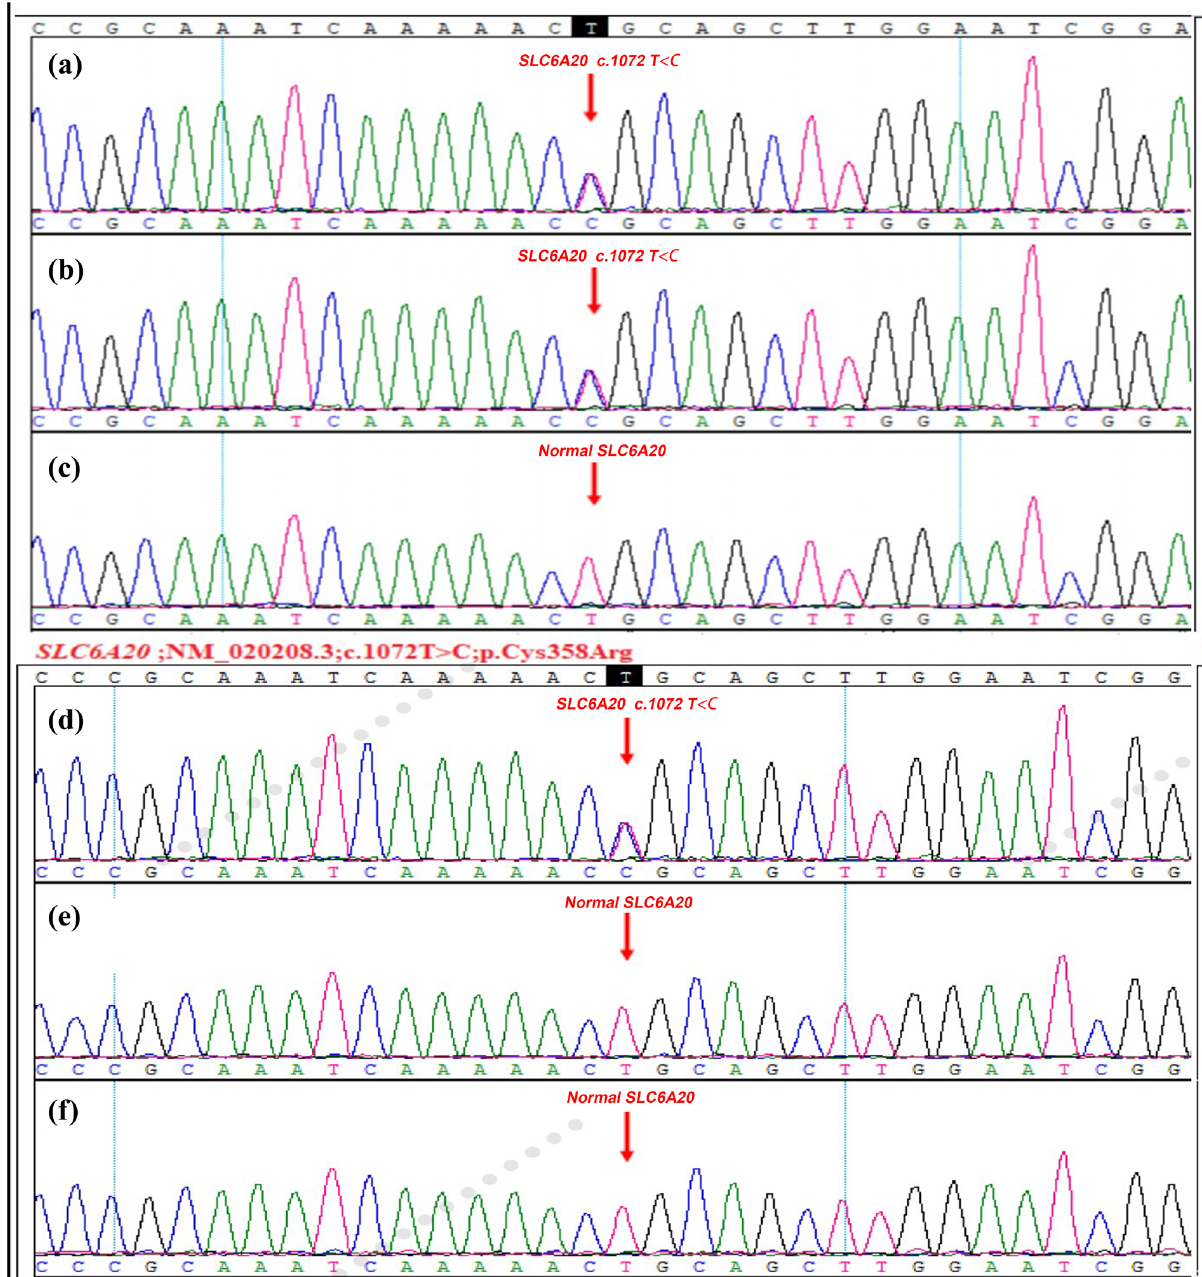
Figure 5: DNA sequencing and Sanger sequencing veri fi cation. ( a, d ) The c.1072T > C heterozygous variation in the SLC6A20 gene exon from the proband ( 2 ) and her sister ( 3 ) . ( b ) The c.1072T > C heterozygous variation in the proband's mother ( 1 ) . ( c, e, f ) The normal gene in the proband ’ s father ( 2 ) , son and